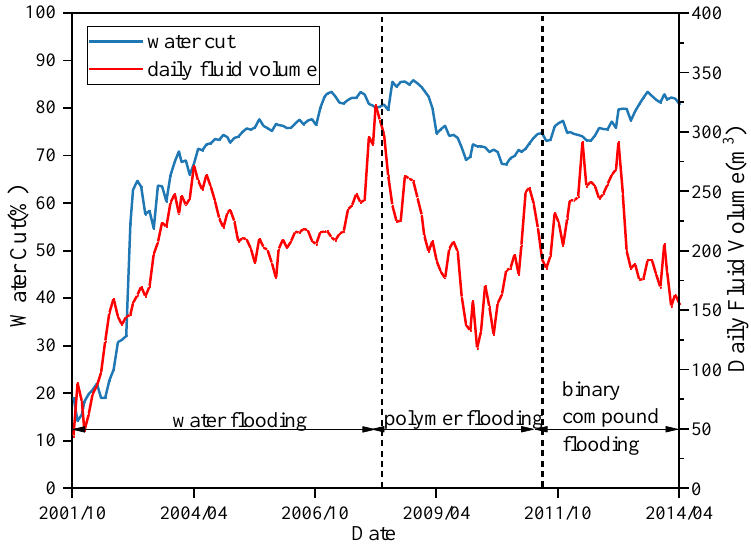
Figure 2. Variation in water cut and daily oil production of well W1.